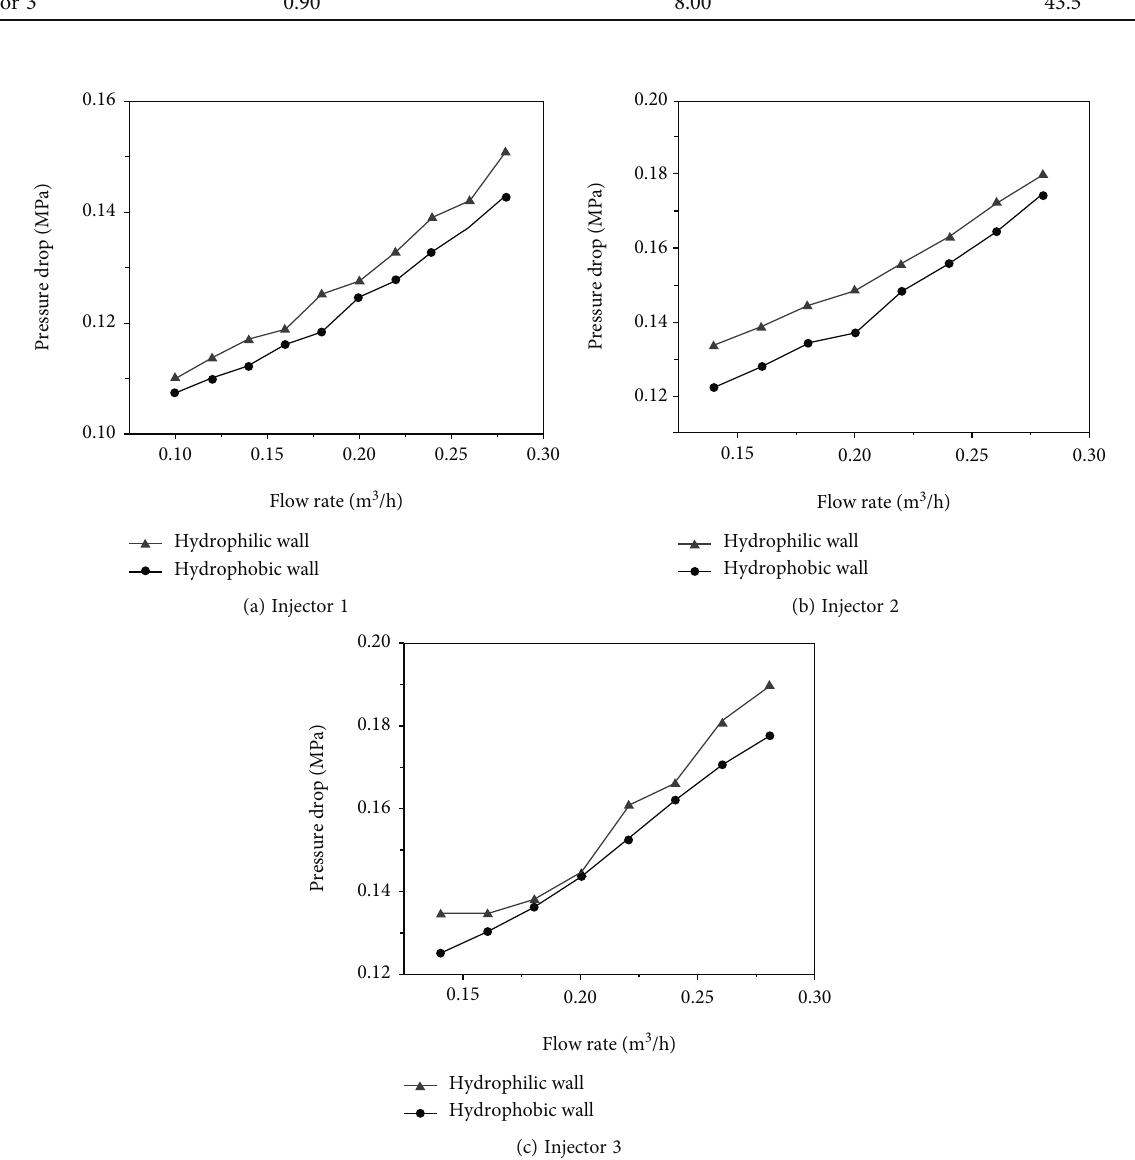
Figure 3: E ff ect of the fl ow rate on the injector pressure drop in di ff erent injectors.